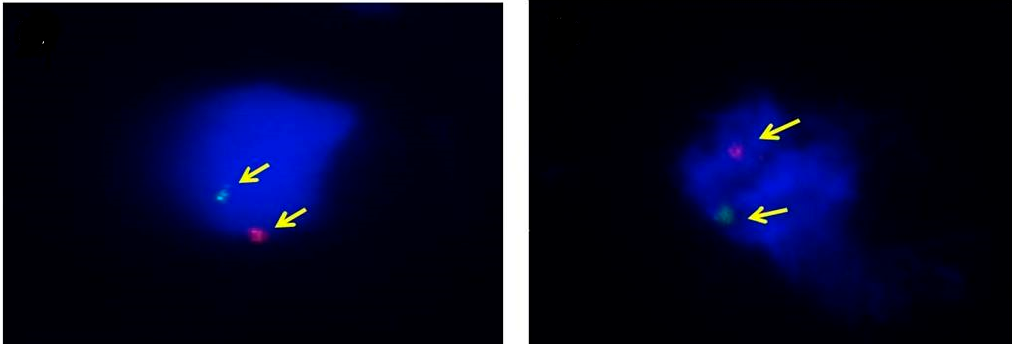
Figure 4. Trophoblast cells from TRIC samples analyzed by FISH. The yellow arrows point to the chromosomes. Male fetuses were labeled with DXZ1 Alpha Satellite SpectrumOrange and DYZ1 satellite III SpectrumGreen probes against the X (red) and Y (green) chromosomes, respectively. Nuclear chromatin was labeled with DAPI (blue).